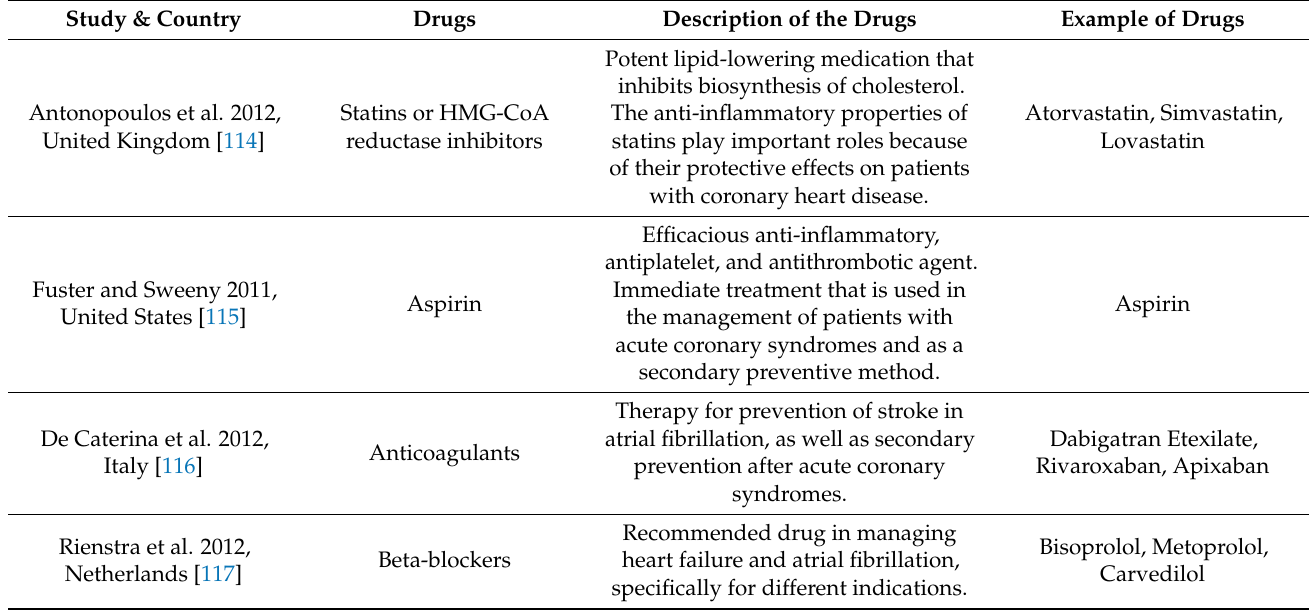
Table 1. The cardioprotective